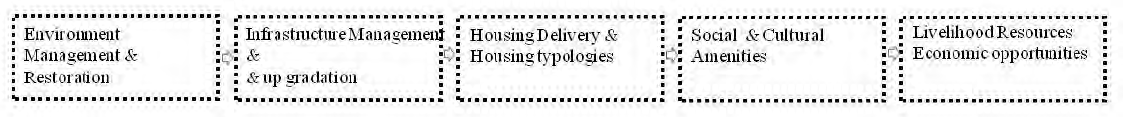
Figure 9. Local AreaPlanning Management and